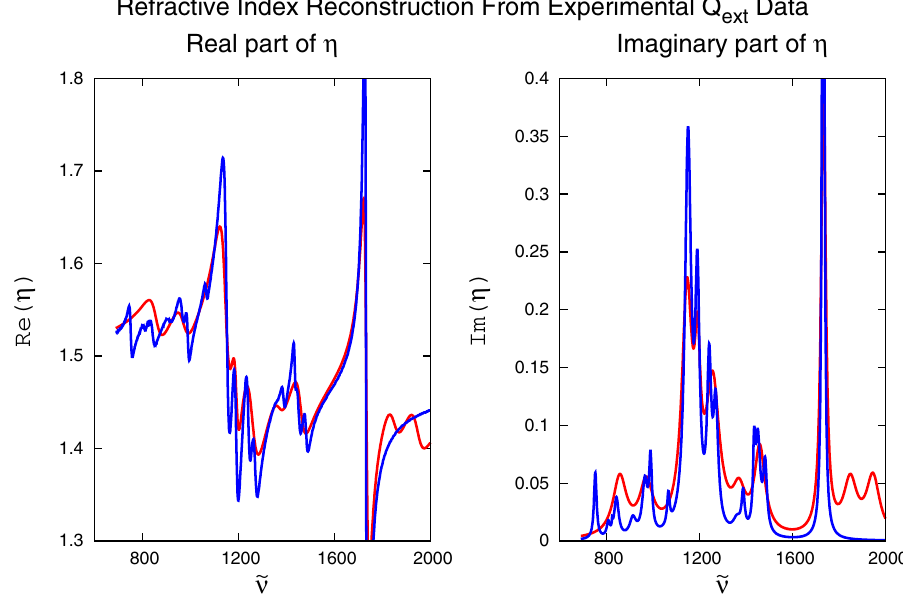
Figure 3. Real-life example of the reconstruction of real and imaginary parts of the complex refractive index η( ˜ ν) of PMMA (red lines) for an experimental PMMA extinction spectrum of a PMMA sphere 19 compared with the experimental refractive index 14 of PMMA (blue lines). 18 Lorentzians were used for the reconstructions. Although the initial guess of the complex refractive index is random, the reconstructions (red lines) of real and imaginary parts of η( ˜ ν) are close to their experimental